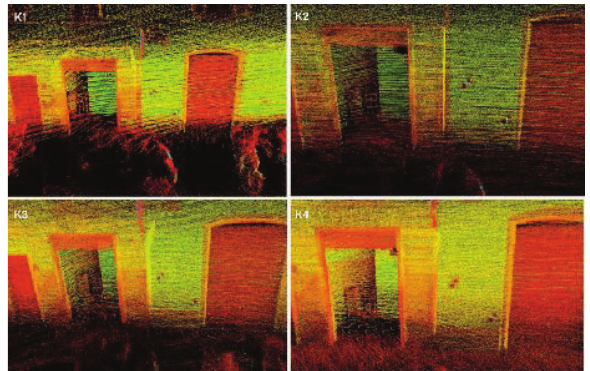
Table 1. the table shows the data regarding the single scan slots: number of trajectories, acquisition time and number of points of the generated cloud. Figure 6. It is possible to observe the variation of the density of the point cloud and consequently the readability of the data in relation to the time of and the number of paths taken.